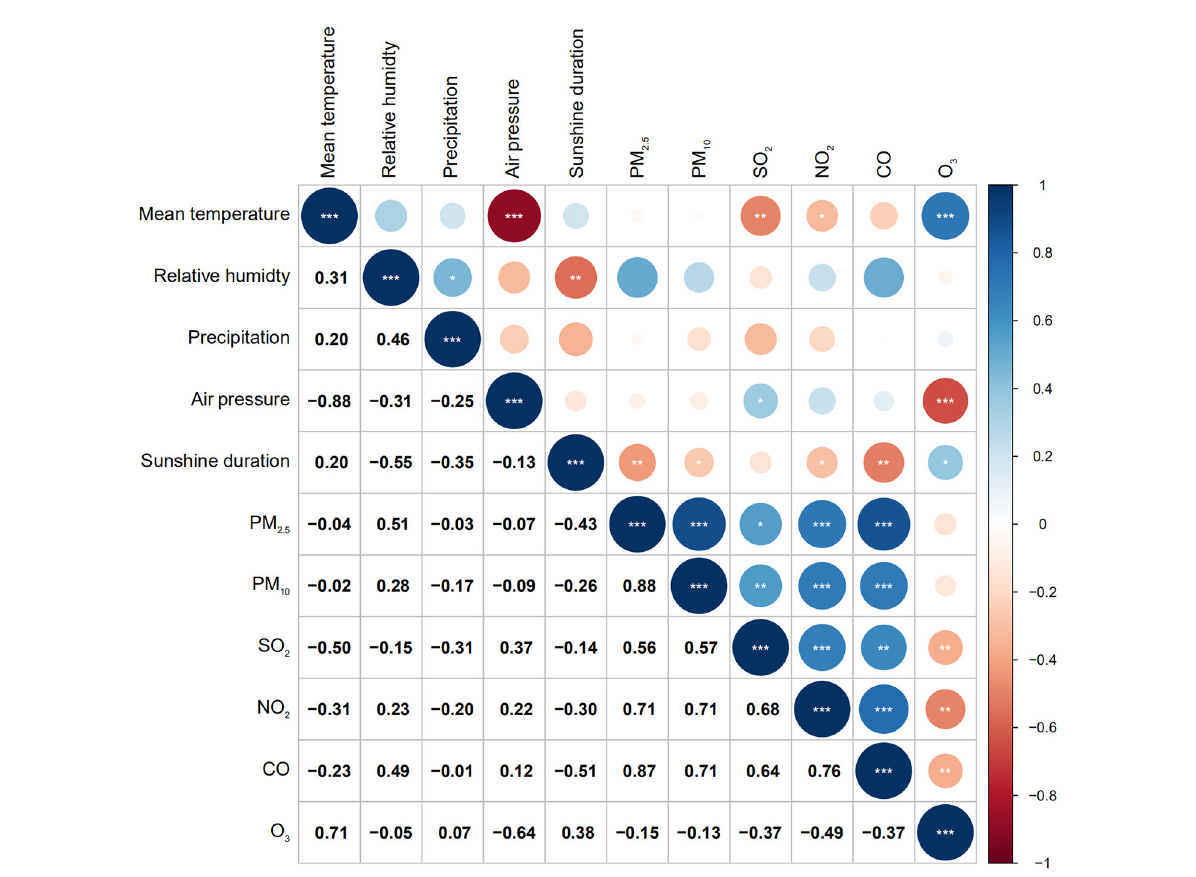
FIGURE1 Spearman correlation coefficients between daily weather conditions and air pollutants in Beijing, China during 2013–2018. * P < 0.05; ** P < 0.01; *** P < 0.001.